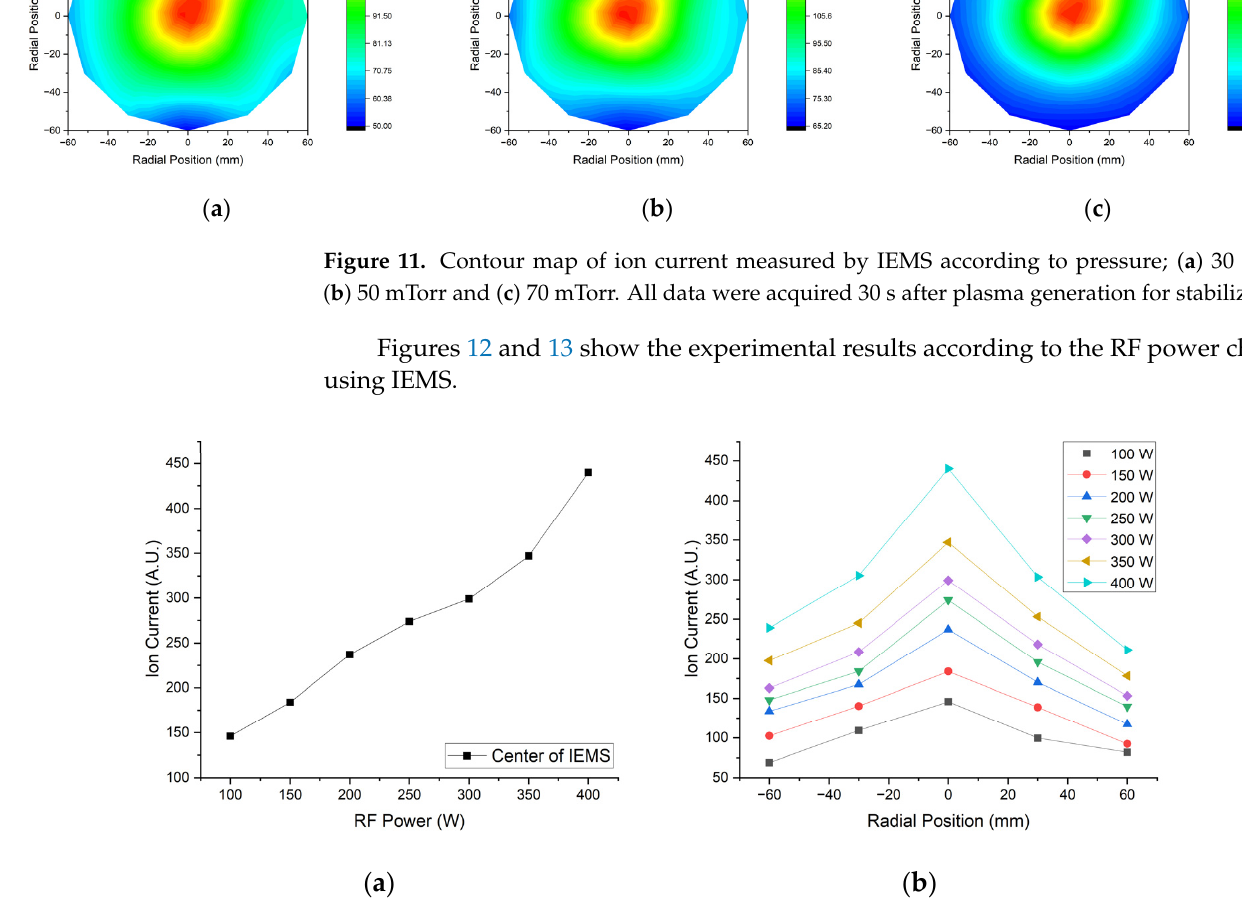
Figure 12. Experimental result according to varying RF power; ( a ) Center position and ( b ) Middle axis. All data were acquired 30 s after plasma generation for stabilization.